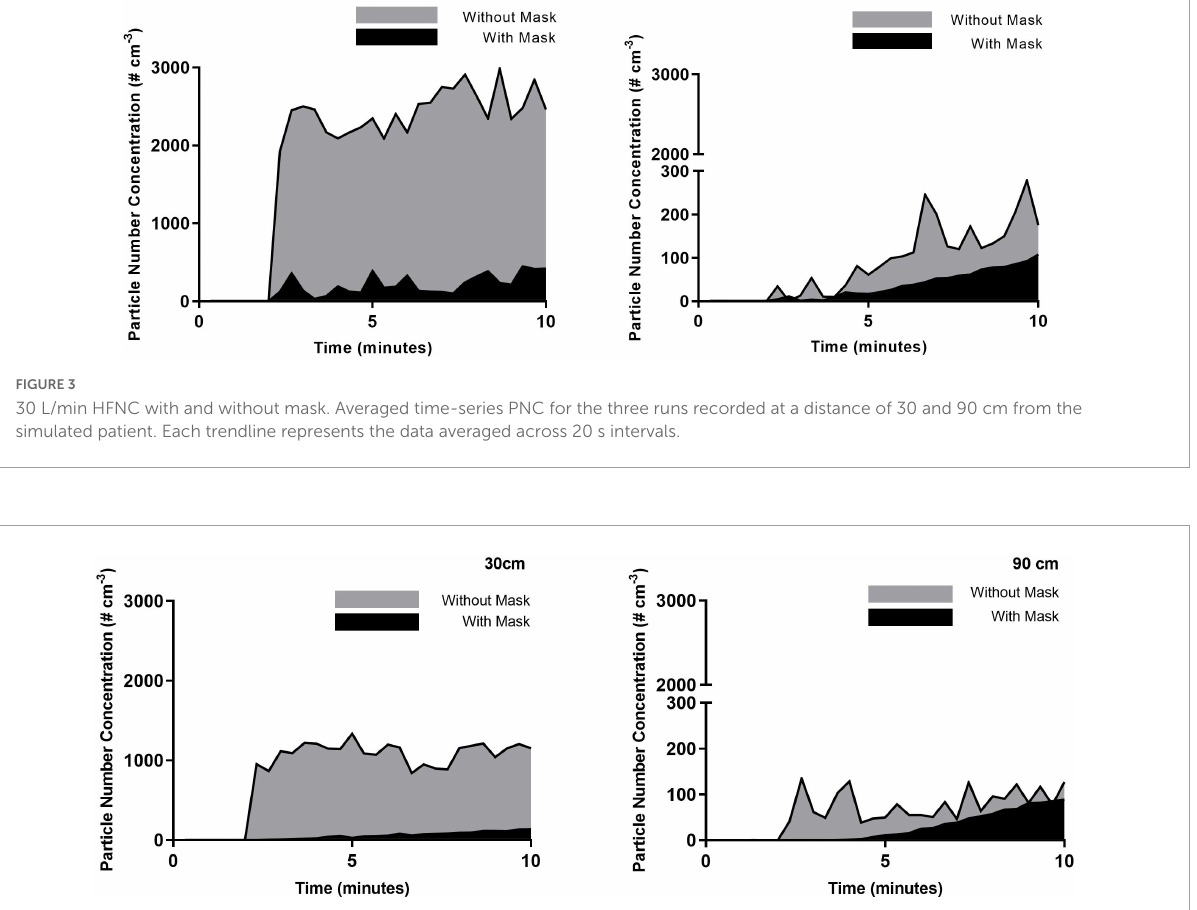
FIGURE4 50 L/min HFNC with and without mask. Averaged time-series PNC for the three runs recorded at a distance of 30 and 90 cm from the simulated patient. Each trendline represents the data averaged across 20 s